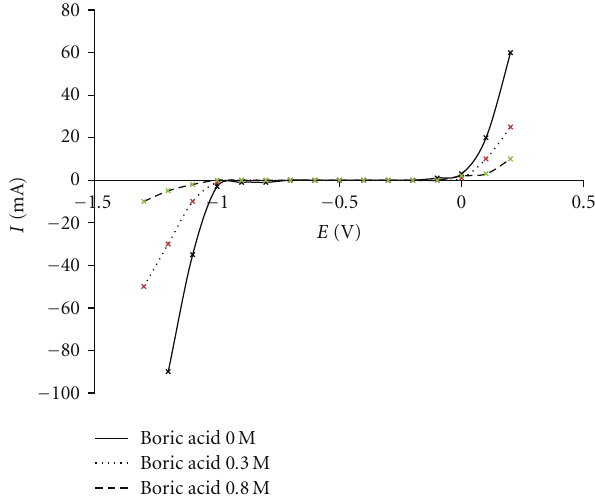
Figure 1: Polarization curves of 0.5 M sodium sulfate solution for di ff erent concentrations of boric